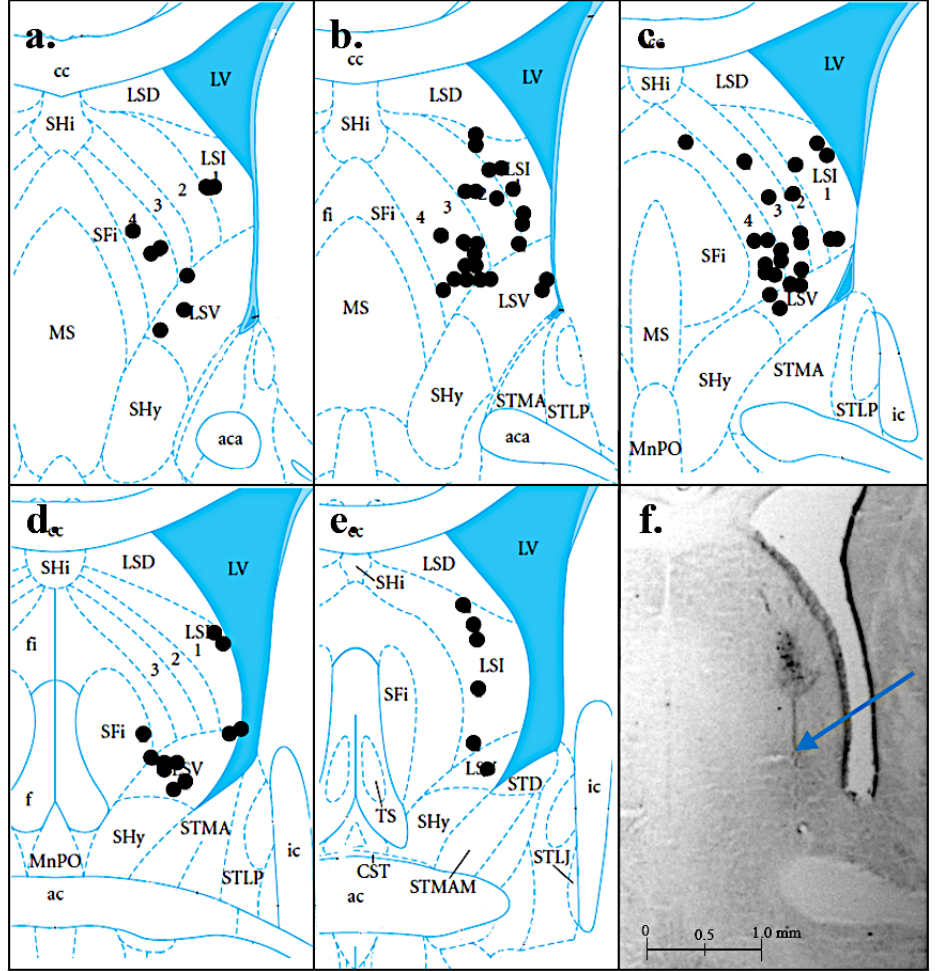
Figure 1. Histology results. Black circles indicate the injection sites in the lateral septum (LS). Panels ( a – e ) show different rat brain sections at interaural coordinates 9.2, 9.1, 9.0, 8.9, and 8.7 (respectively) based on Paxinos and Watson (2013) [39]. Panel ( f ) shows a histological image of a cresyl violet stained rat brain section showing a representative injection site (marked by the arrow) at 9.0 interaural coordinates. Brain sections are reprinted from The Rat Brain in Stereotaxic Coordinates: Hard Cover Edition (7th), by G. Paxinos, and C. Watson, 2013. Elsevier. by Academic